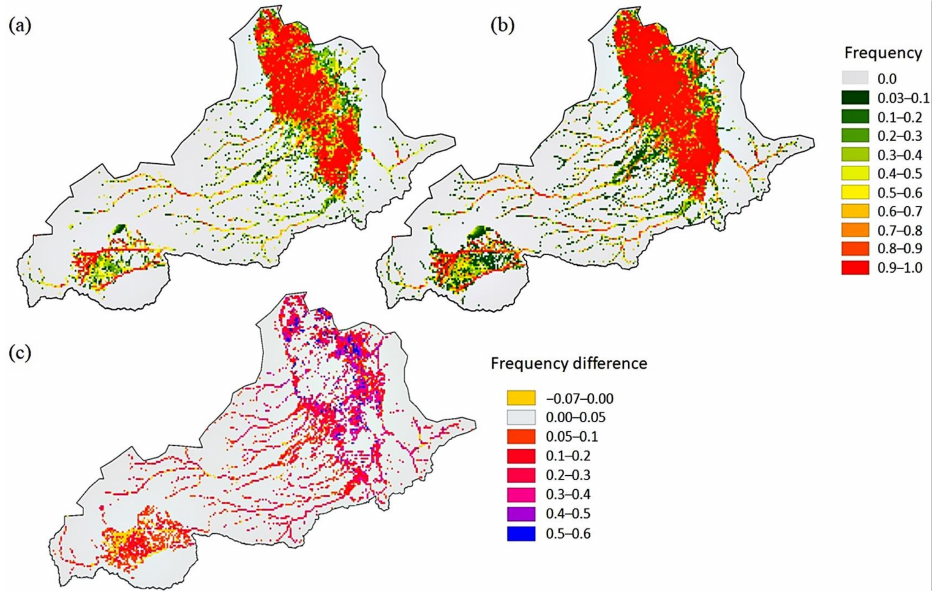
Figure 8. Spatial distribution of the inundation frequency averaged for ( a ) the top 20 rainfall events (historical simulation), ( b ) the top 36 rainfall events (future simulation), and ( c ) inundation frequency difference between the top 20 past and top 36 future rainfall events.